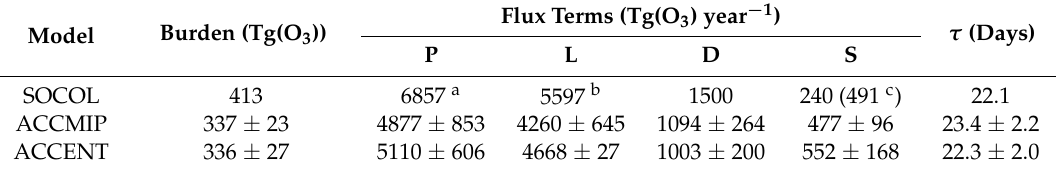
Table 3. Tropospheric ozone burden (B) and budget statistics for SOCOLv3, and the ACCMIP and ACCENT model evaluations (mean ± stddev) for the year 2000. For SOCOL the 1995–2005 mean is shown. The 150 ppb ozone level is used to define the tropopause. The flux terms involve chemical production (P) and loss (L), dry deposition (D), and stratospheric influx (S). The stratospheric influx is calculated as a residual of production and loss terms (S = L + D − P) or directly using the ozone origin tracers. The lifetime τ is calculated as follows: τ = B/(L +